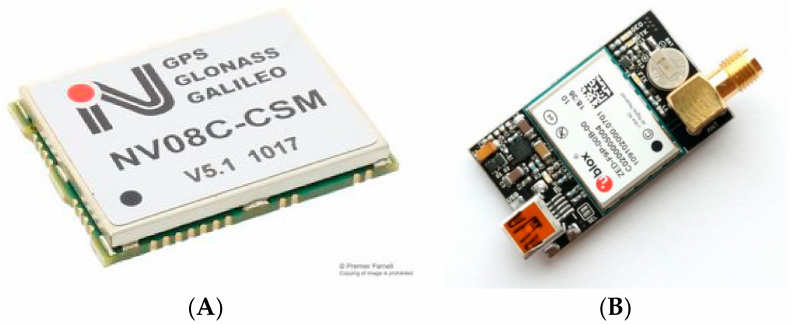
Figure 2. ( A ) NV08C-CSM low-cost single-frequency receiver; ( B ) ZED-F9P low-cost dual-frequency